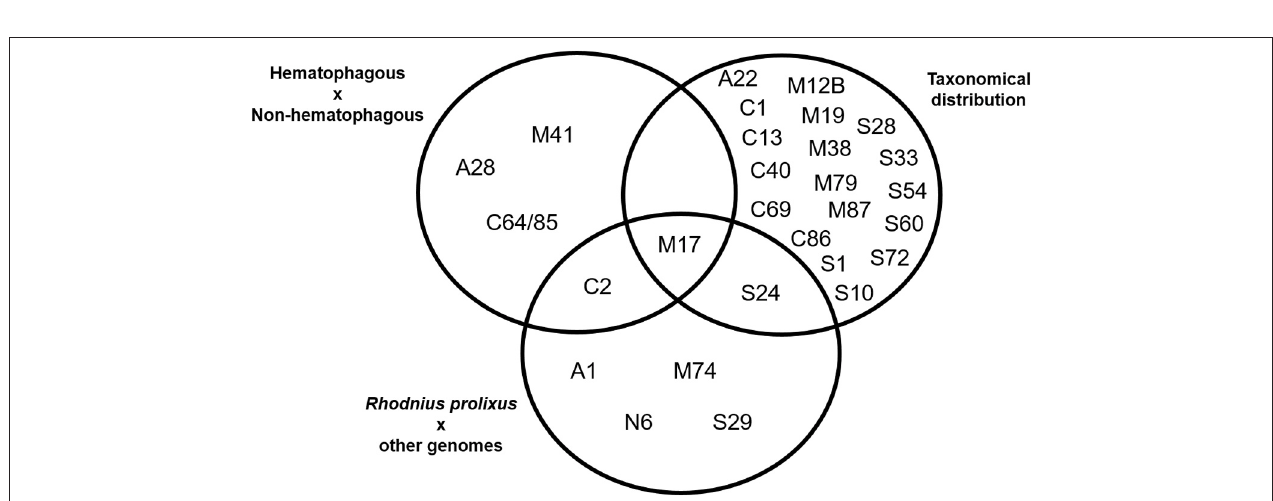
FIGURE 3 | Gene frequency comparisons in three peptidase families. (A) Comparison between hematophagous and non-hematophagous species of peptidase gene frequencies in family C2. (B) Comparison between hematophagous and non-hematophagous species of peptidase gene frequencies in family M17. (C) Peptidase frequency distribution in five groups defined by the taxonomic order in peptidase family S24. Boxes are frequencies between 25 and 75%, with medians; error bars represent non-outlier ranges; ◦ are outliers; * are extremes.